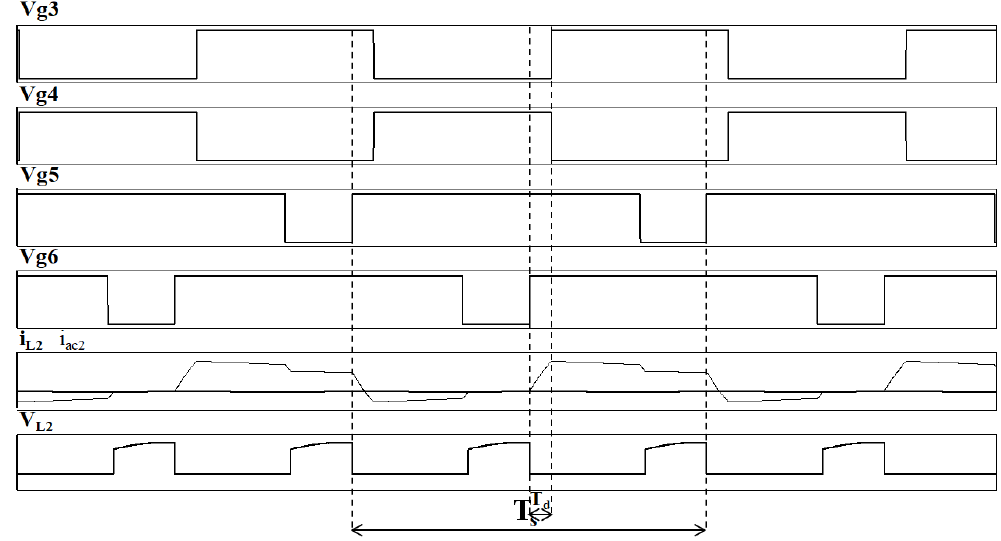
Figure 9. Improved secondary-side waveforms for the modified PSM.